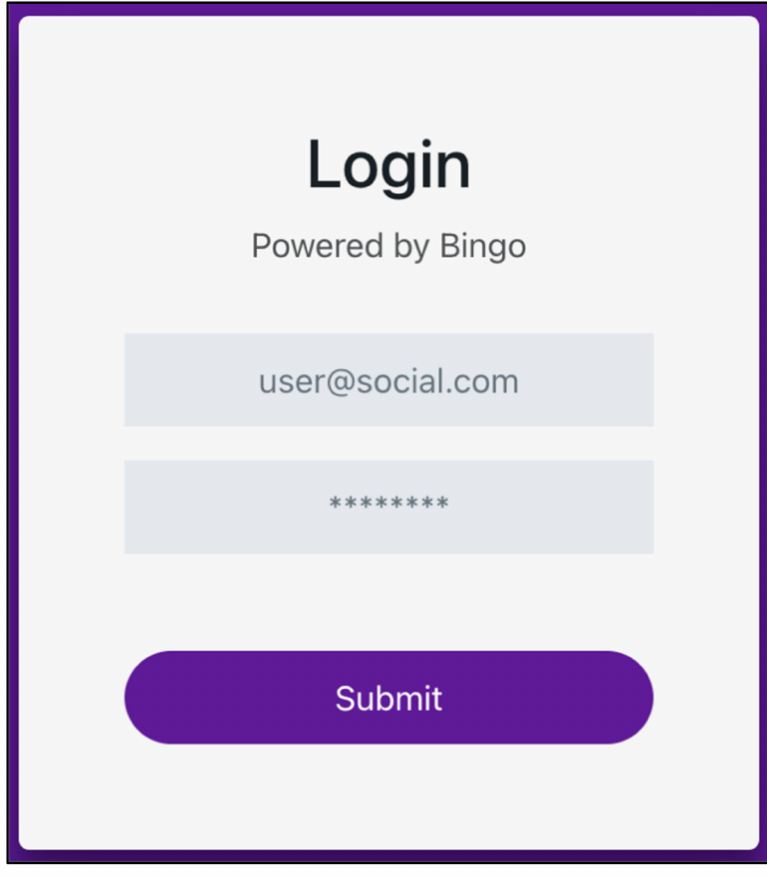
Figure 8. Bingo React in “login”